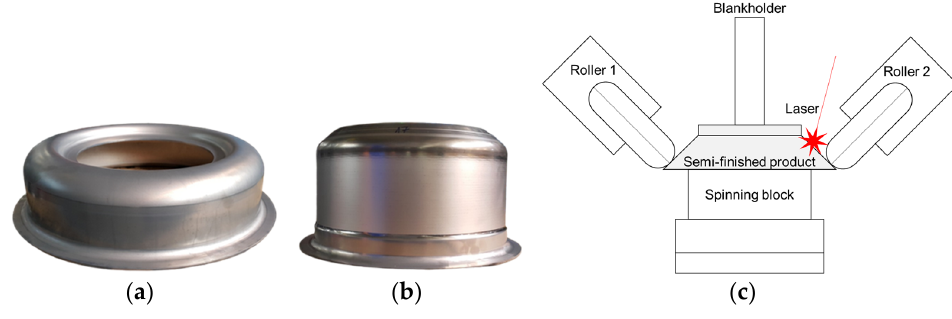
Figure 2. Preformed drawpiece ( a ), finished product ( b ) and stand ( c ). In order to obtain an axisymmetric product with a varying thickness of the drawpiece wall, experiments were designed to verify the optimal shear spinning parameters. The boundary conditions and key process parameters were determined from the results of extensive cold and laser heated shear spinning studies. It was decided to conduct investi- gations for three factors at two established levels. The factors selected were the rotational speed of the spinning block (R), the feed rate of the roller (S) and the heating of the material (H). A 2 3 − 1 experiment was planned. As a starting value for determining the parame- ter levels, the parameters of the reference test P 0 were adopted as: R 0 = 220 rpm and S 0 = 20 mm/min, H 0 = 0. The experimental design was based on levels increased in rela- tion to the reference values by 15% for the rotational speed, by 20% for the feed rate and by 50% for both rotational speed and feed rate. The differentiated increase for the values of the first level is a result of the need to examine the influence of the feed coefficient (f), defined as the ratio of feed rate to rotational speed. For equal percentage increments of the reference levels, the value of the feed coefficient would be the same in all cases. There are two levels of heating factor: the use of heating (1) or no heating (0). The levels of factors are shown in Table 3. The trial plan and the reference test conditions are shown in Table 4. Table 3. Levels of